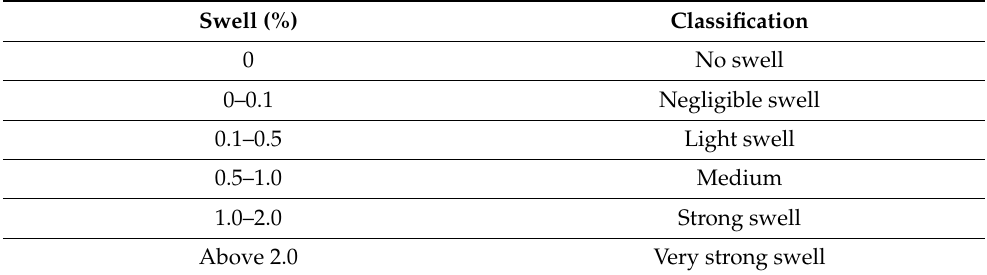
Table 5. Swell severity